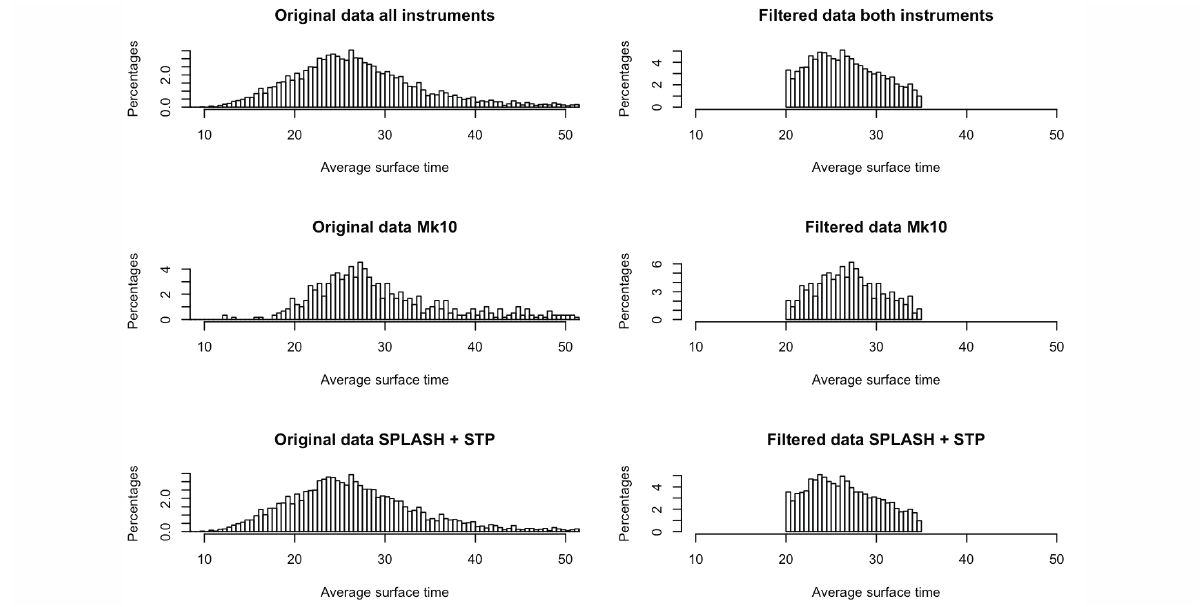
Figure 4: Comparison of the original data on the accumulated time (surfacing time) spent within 0-2m for two transmitter types (Mk10 and Splash/STP tags) before filtering of the data and after filtering. For SPLASH and STP tags the filtering includes data where the sum of all bins was larger than 98 and the surfacing time was within 20 to 35. For Mk10 tags the filtering includes data where the surfacing time was within 20 to